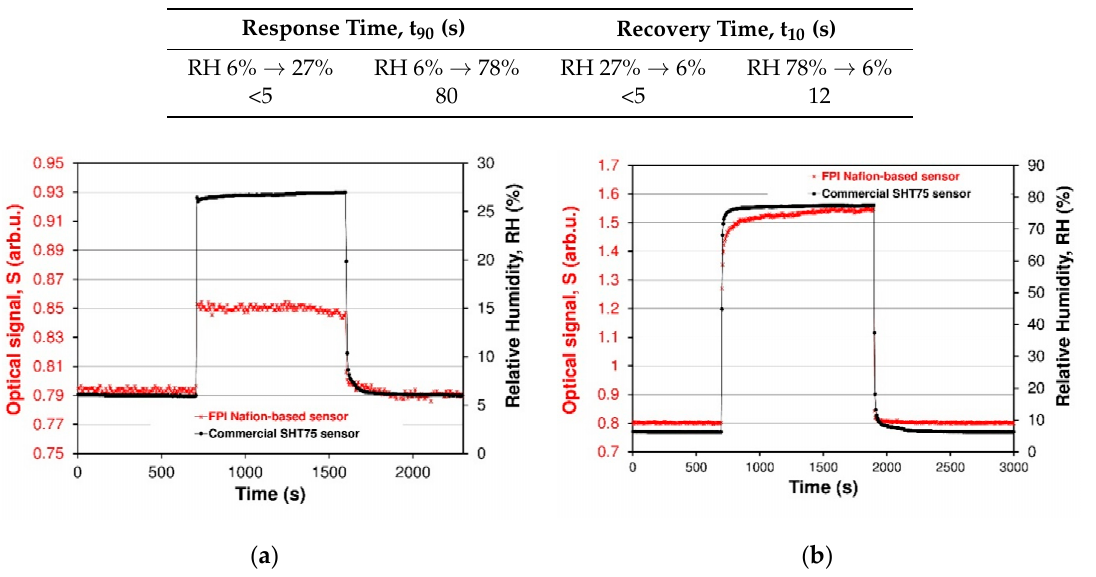
Table 1. Response and recovery times of humidity FPI sensor.